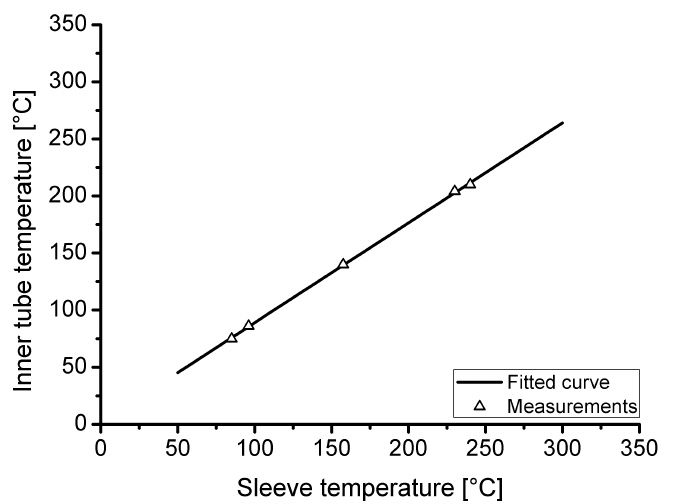
Figure 3. Correlation between heating sleeve temperature and achieved temperature within the tubular autoclave at the centre of the heating